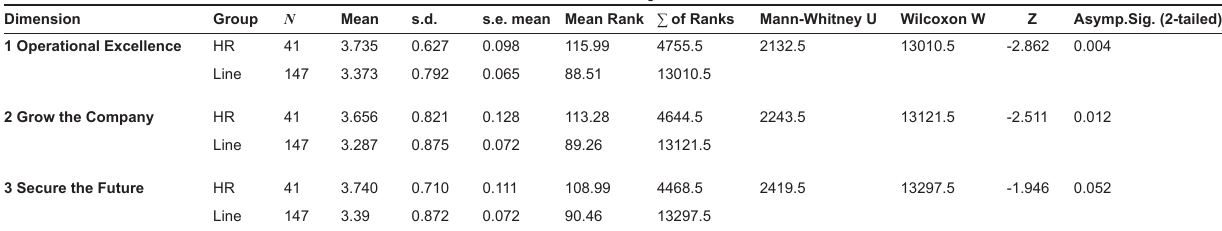
TABLE 9 Mean differences, mean ranks and tests of significance of the scale sub-sections